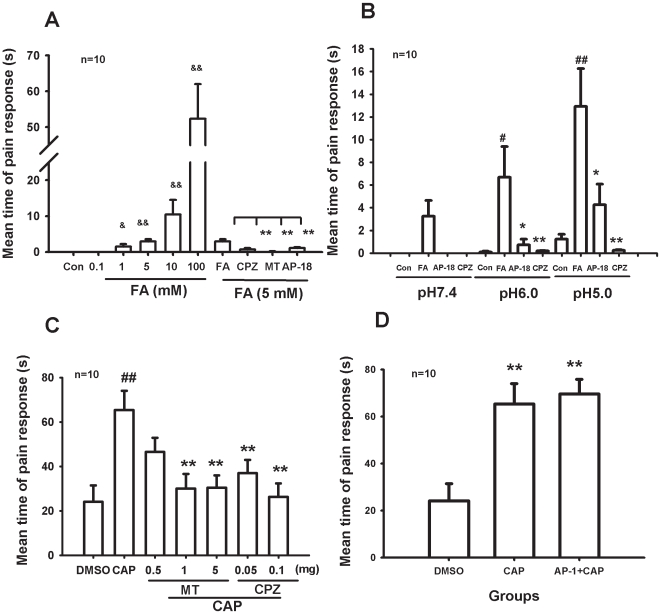
Capsaicin- or formaldehyde (100 µl/paw)-induced acute pain responses.(A) Melatonin, capsazepine and AP-18 attenuated formaldehyde-induced pain responses. (B) Low pH enhanced formaldehyde-induced pain responses. (C) Melatonin (MT) and capsazepine (CPZ) blocked capsaicin (0.5 mM)-induced pain responses. (D) AP-18 did not block capsaicin-induced pain responses. Con: control; DMSO: vehicle; CAP: capsaicine. * p<0.05, ** p<0.01, ##
p<0.01, &
p<0.05, &&
p<0.01, all compared with respective controls. n = 10.